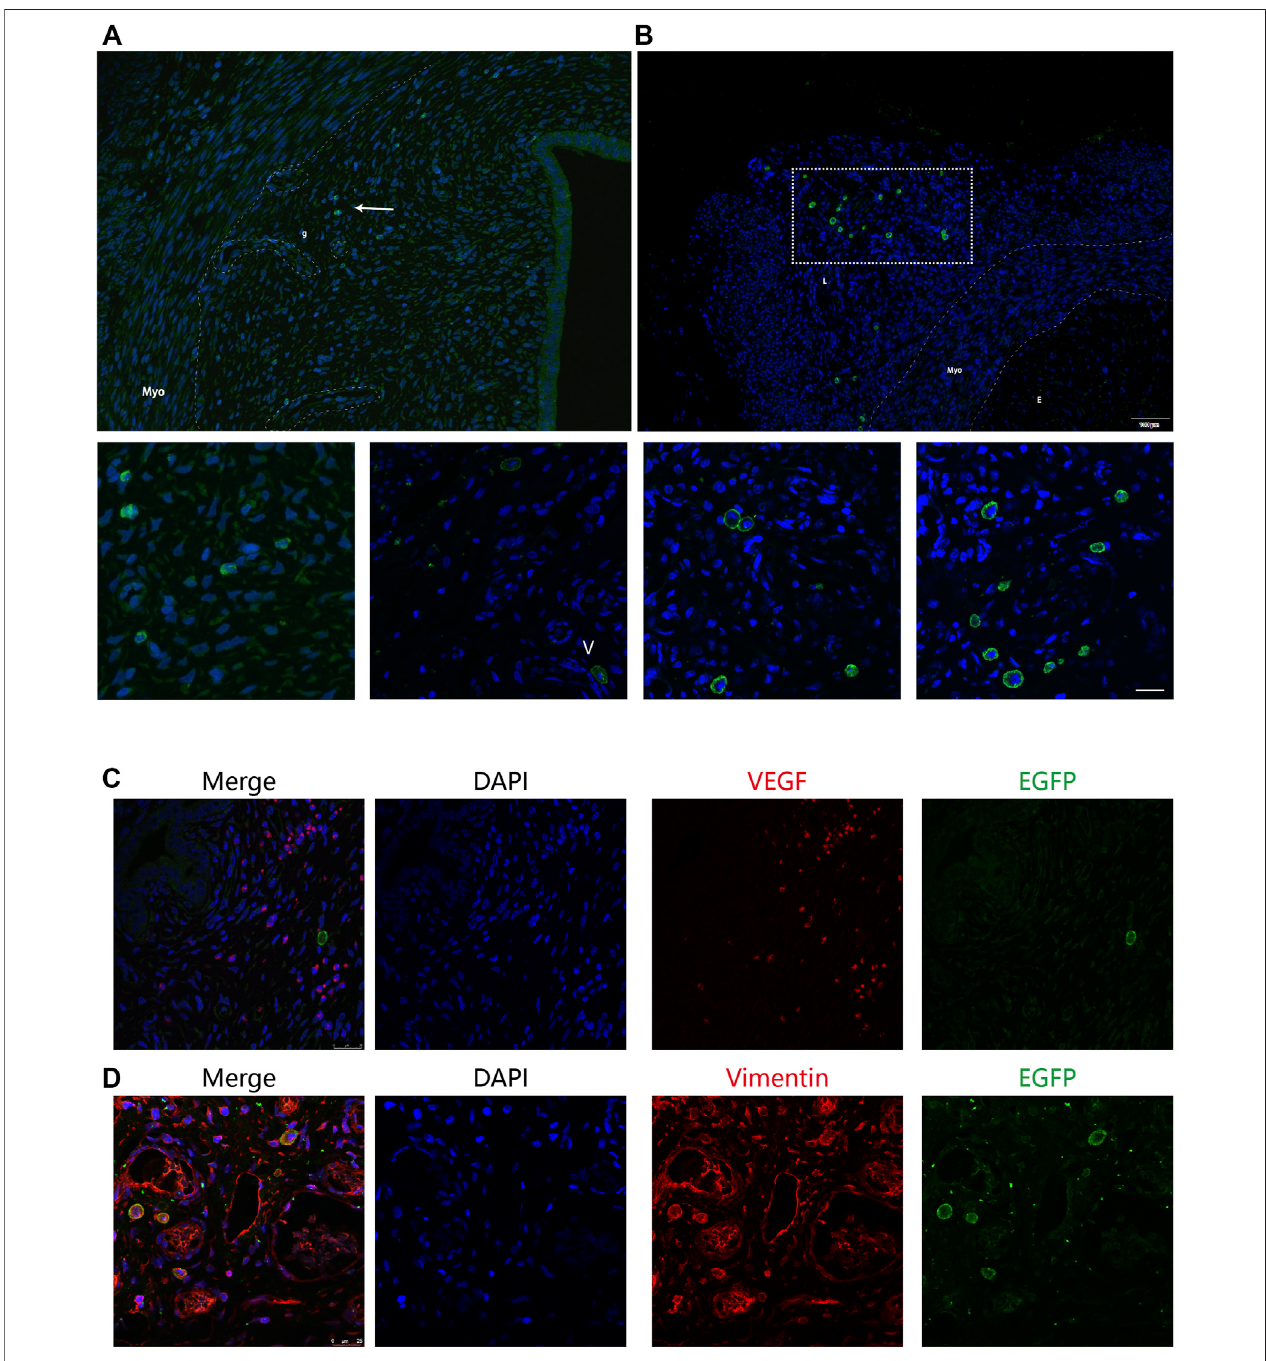
FIGURE 4 | Precise distribution and differentiation of GFP + BMSCs. The murine uterus tissue consists of endometrial (glandular and luminal) epithelium, stroma, and myometrium. (A) Nearly all the GFP-positive cells were localized in the stroma, but not in the epithelium or myometrium. The distribution of GFP-positive cells is concentrated around the vessels and glands, indicated by the white arrow. g: glands, V: vessels. (B) Some GFP-positive cells were located around the vessels in the surroundingligamentsofuterusintheintra-arterialinfusiongroup.Myo:myometrium;E:endometrium;L:surroundingligaments.Theuterinesectionswerestained with anti-GFP and anti-vimentin (C) or anti-VEGF (D) GFP + BMSCs co-localized with vimentin marker but not VEGF.